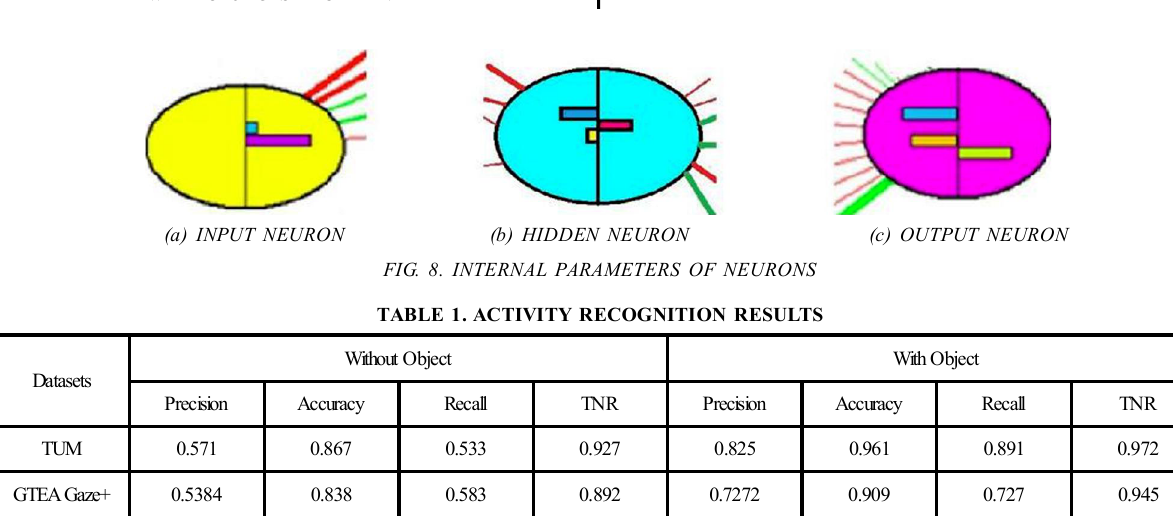
FIG. 7. NEURAL NETWORK FOR ACTIVITY RECOGNITION WITH OBJECTS FROM FPV